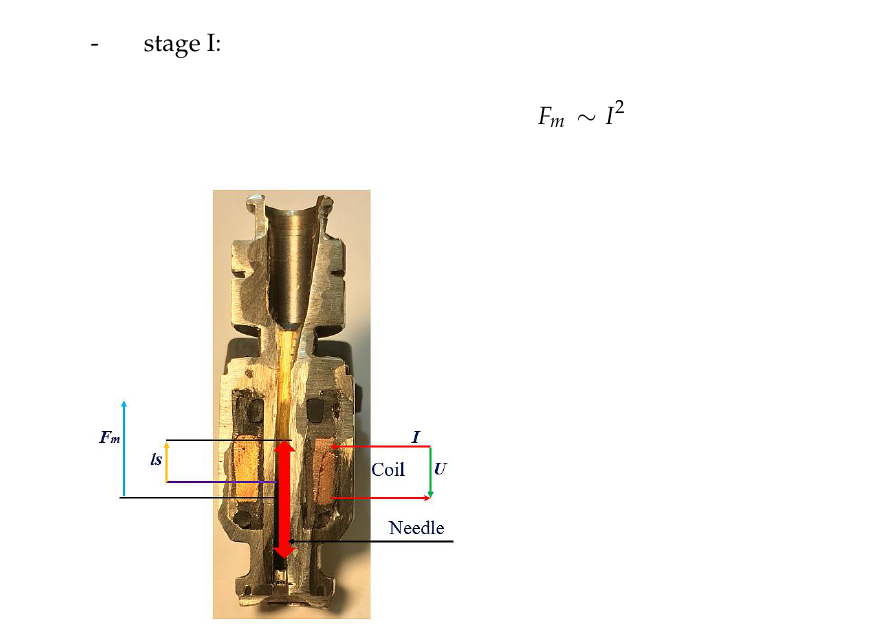
Figure 3. Distribution of ferromagnetic materials in the injector housing.